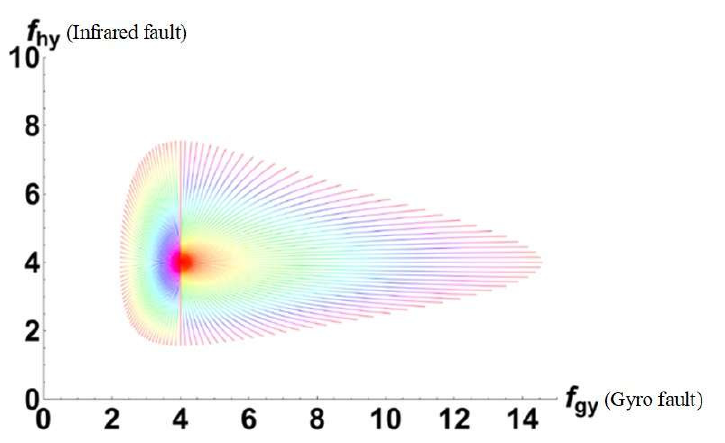
Figure 2. The FID unit circle of the compound fault f 1